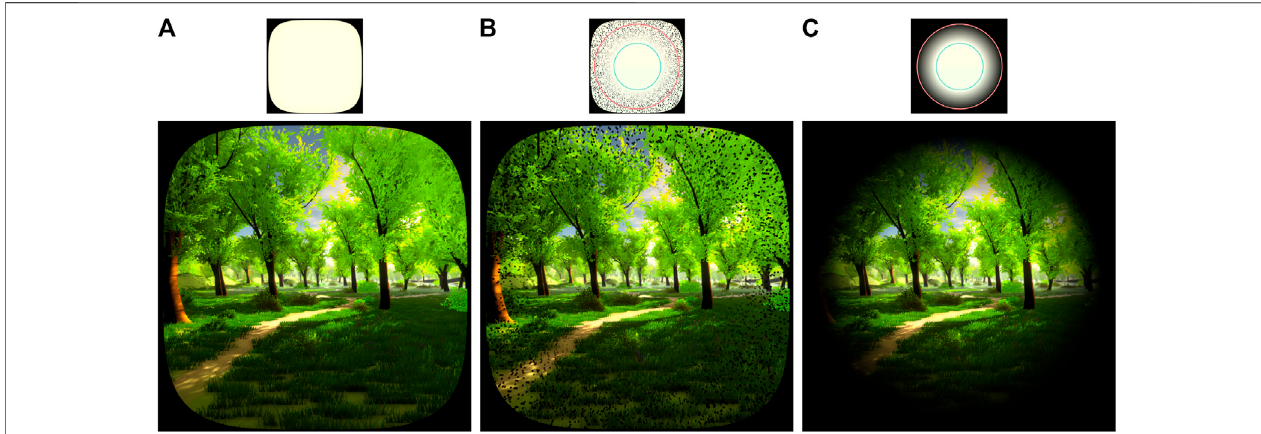
FIGURE 1 | The Granulated Rest Frames design allows the visual recreation of most details from the original image by exploiting human ’ s ability to discern objects even in the presence of visual noise. (A) Reference Image: a virtual scene with no modi fi cations; (B) Granulated Rest Frames: the scene with Granulated Rest Frames using a 36 + IFOV (green circle at the top diagram) and 80 + OFOV (red circle at the top diagram) soft-edged circular cutout; (C) FOV Restrictor: the scene using a FOV restrictor with same IFOV and OFOV parameters.